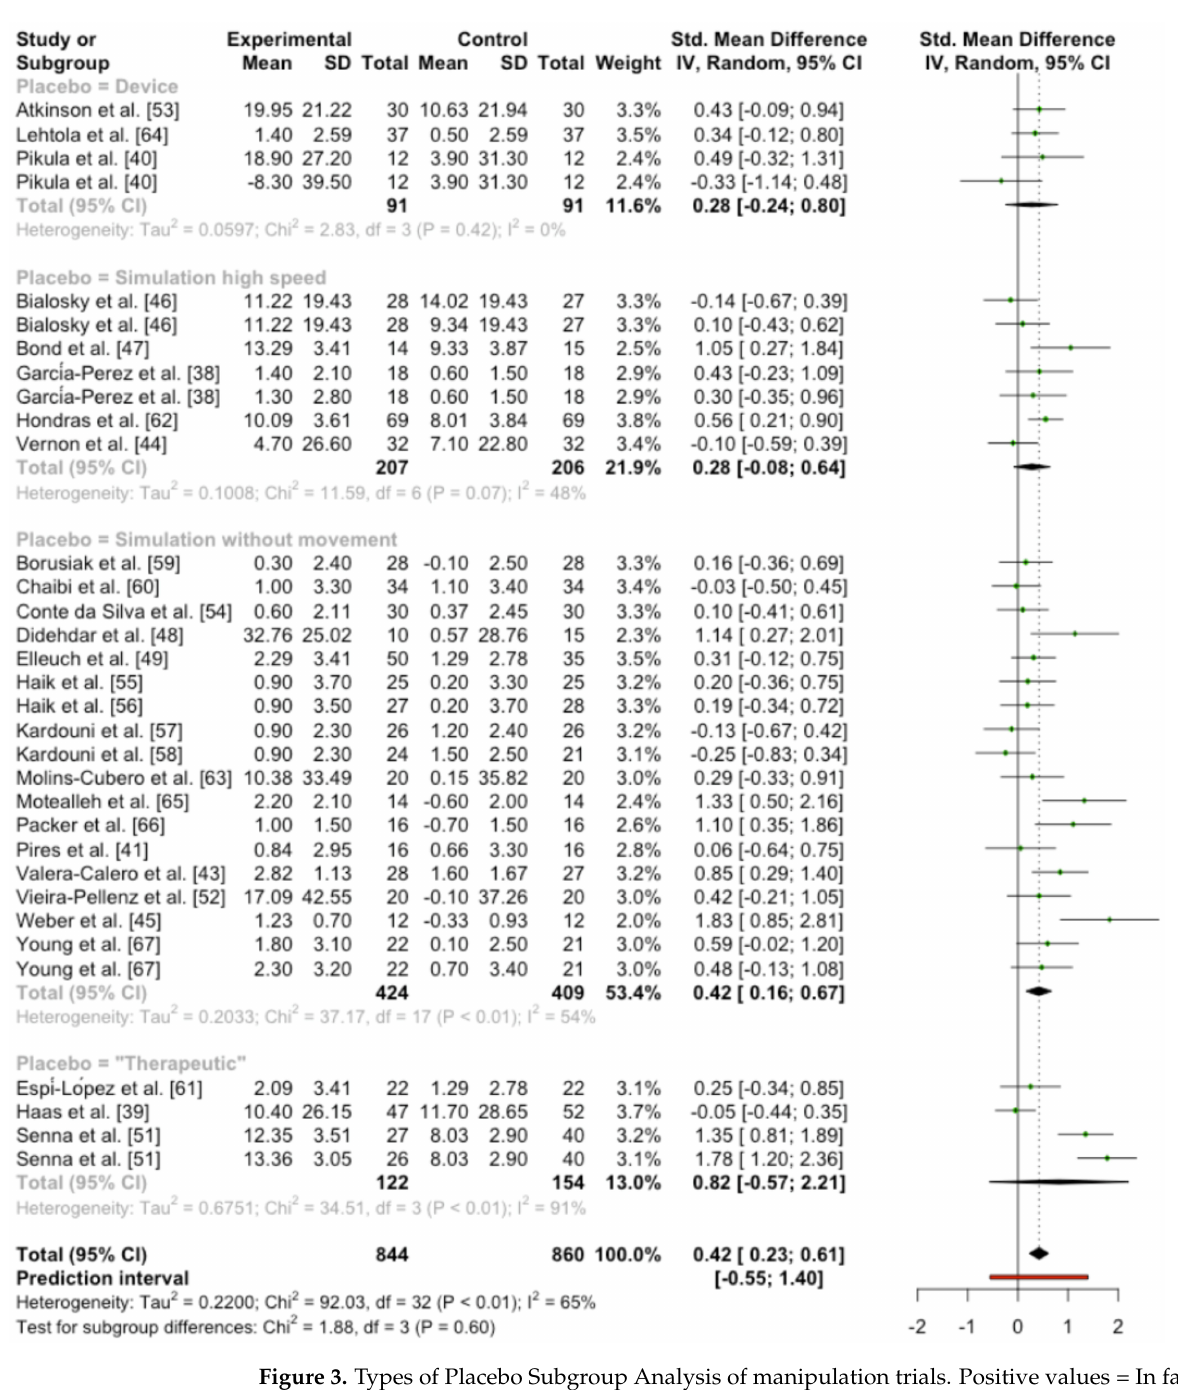
Figure 3. Types of Placebo Subgroup Analysis of manipulation trials. Positive values = In favor of intervention/Negative values = In favor of sham intervention. Standard Deviation (SD); Standard (std); Inverse Variance (IV); Confidence Interval